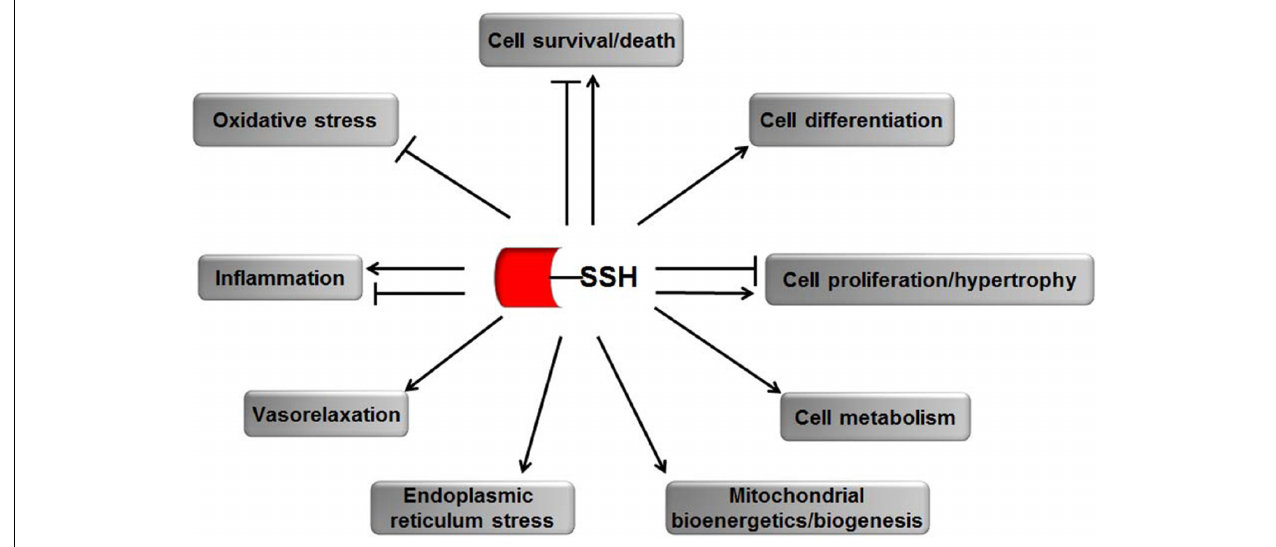
FIGURE 2 | The biological functions of S -sulfhydration by H 2 S. → means stimulating effect, whereas (cid:97) means inhibitory